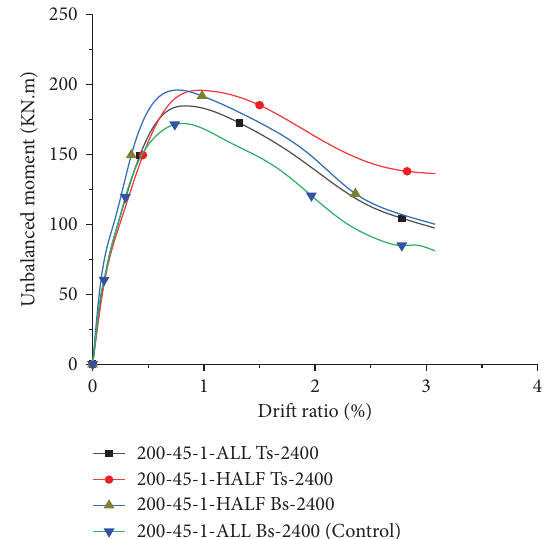
Figure 40: Efect of post-earthquake fre exposed surfaces on unbalanced moment drift